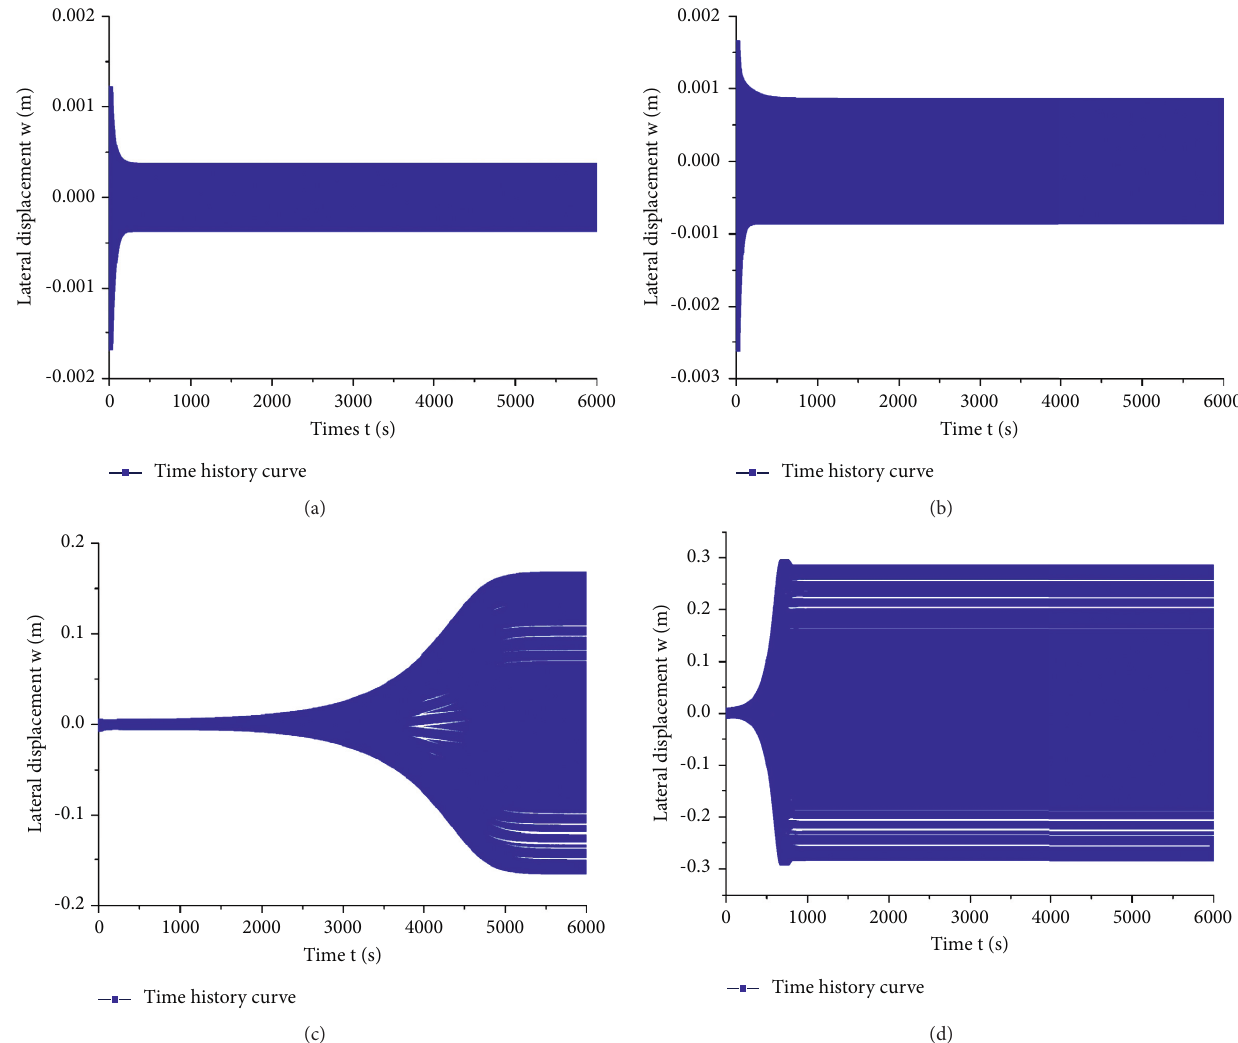
Figure 13: Time history curve of mid-span displacement with different number of pedestrians on the footbridge. (a) N